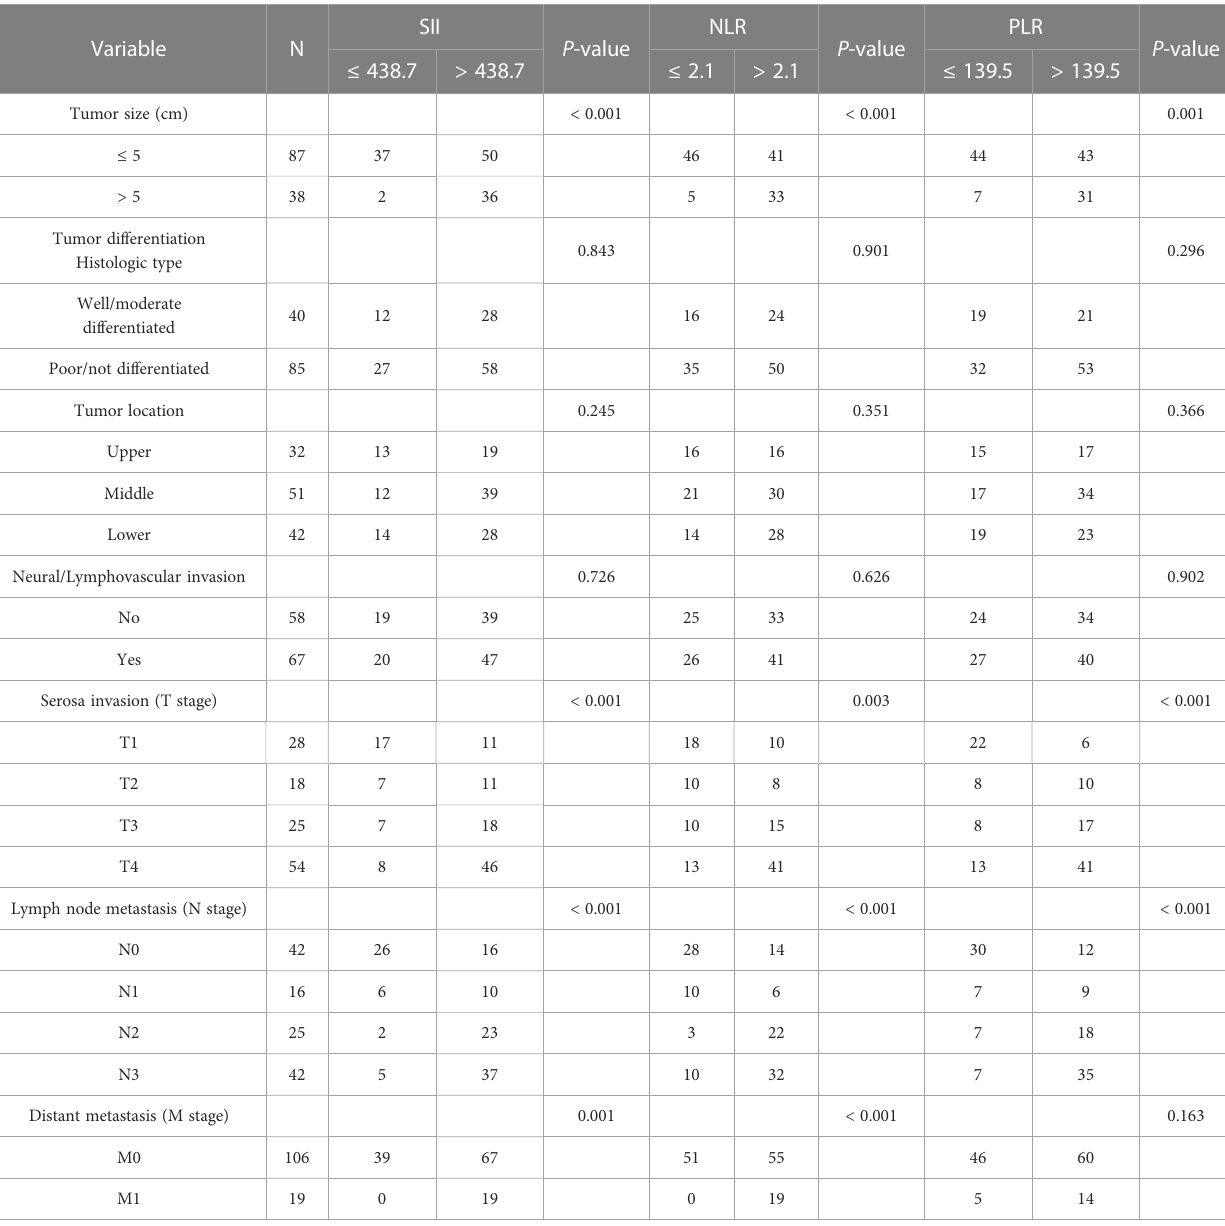
PLR, platelet-lymphocyte ratio; NLR, neutrophil-lymphocyte ratio; SII, systemic immune-in fl ammation